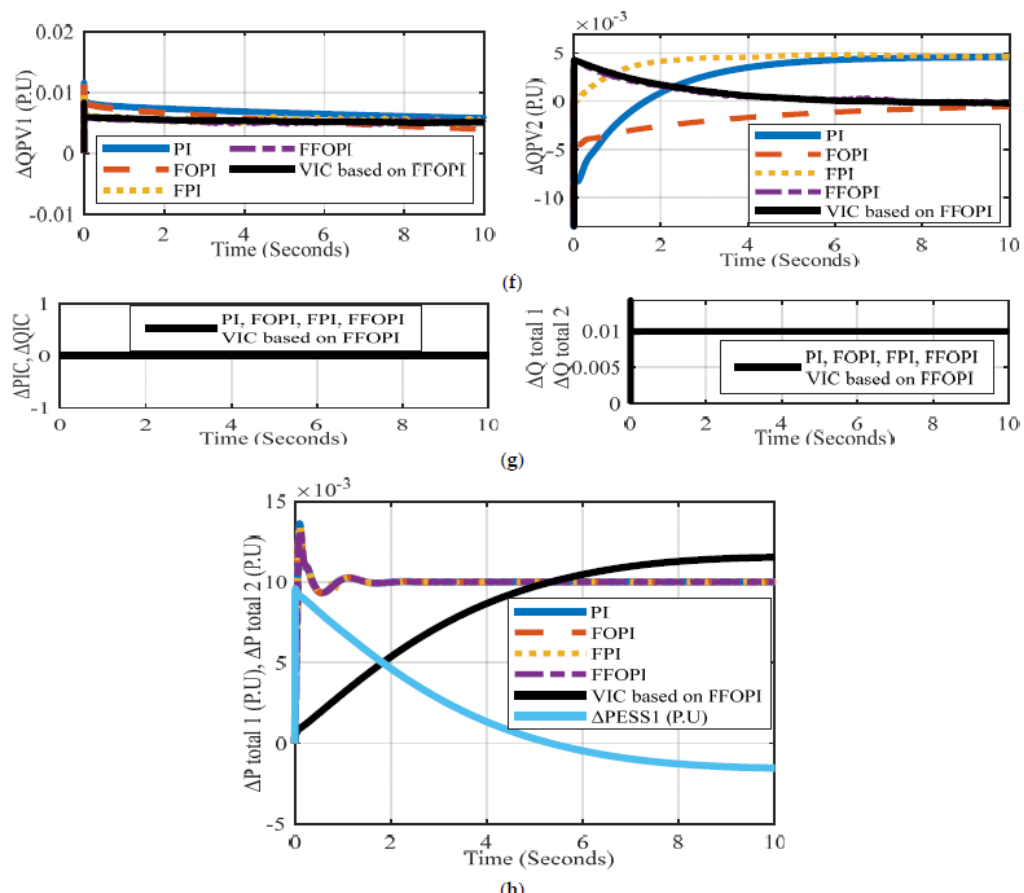
Figure 19. M 1 and M 2 ’s active and reactive power measurements versus time for each controller at disconnected tie line disturbance: ( a ) ∆ P W1 (PU), ∆ P W2 (PU), ( b ) ∆ P PV1 (PU), ∆ P PV2 (PU), ( c ) ∆ P BG1 (PU), ∆ P BG2 (PU), ( d ) ∆ P DE2 (PU), ∆ Q DE2 (PU), ( e ) ∆ Q W1 (PU), ∆ Q W2 (PU), ( f ) ∆ Q PV1 (PU), ∆ Q PV2 (PU), ( g ) ∆ P IC (PU), ∆ Q IC (PU), ∆ Q total 1 (PU), ∆ Q total 2 (PU), ( h ) ∆ P total 1 (PU), ∆ P total 2